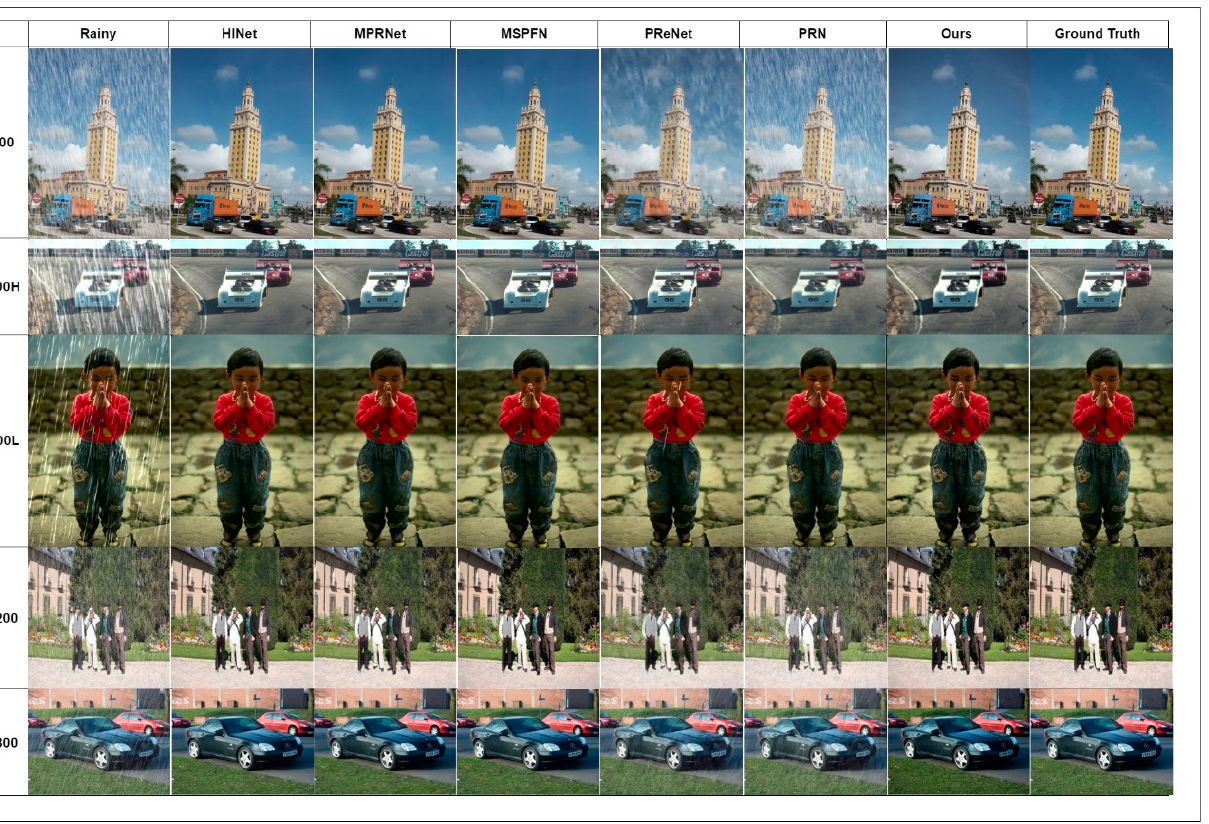
Figure 9. Qualitative results on synthesized datasets. Table 3. Average PSNR and SSIM comparison on the synthetic datasets Test100, Rain100H, Rain100L, Test2800, and Test1200.